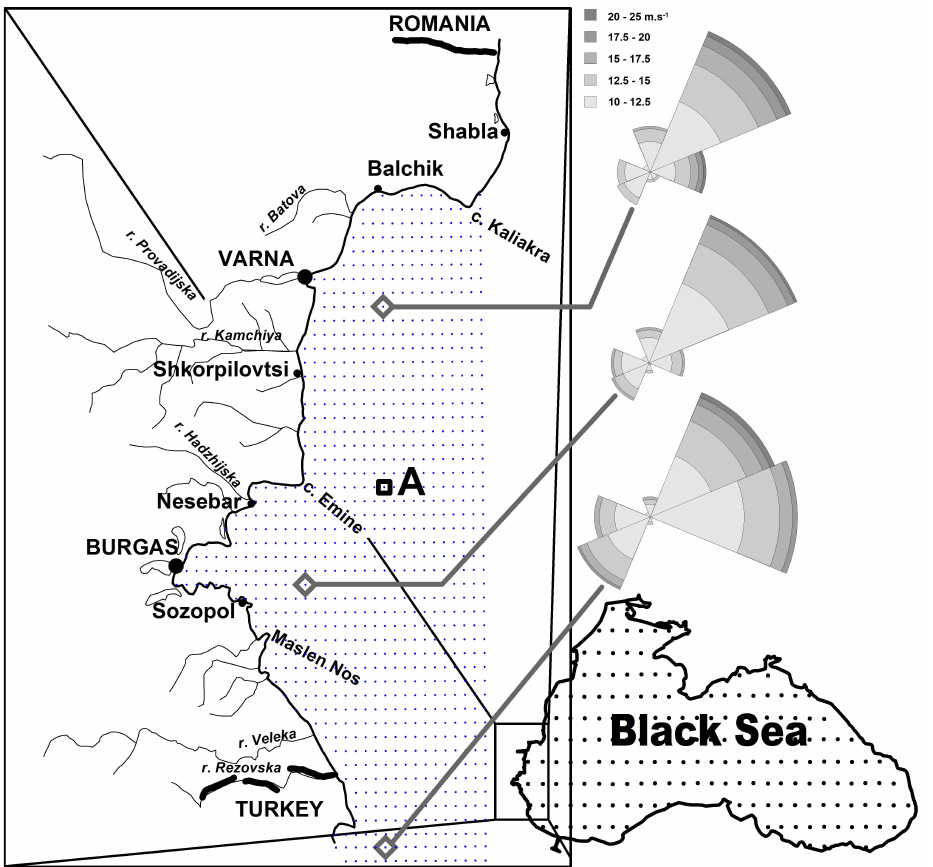
Fig. 1. Location of the study area with modelling grids for the Black Sea and its western shelf. The location of the grid point for which storm properties were estimated is denoted by letter A. Wind roses (wind velocity > 10ms − 1 ) for northern, central and southern portions of the shelf are constructed after Valchev et al.